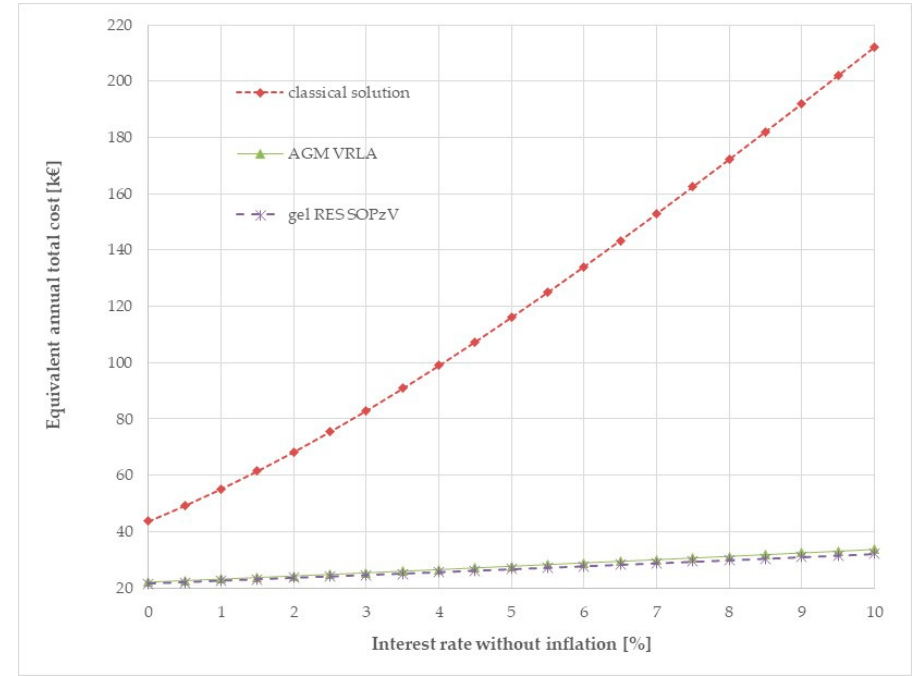
Figure 19. Equivalent annual total cost with respect to the interest rate without inflation for the best combinations of PVs, battery type (AGM VRLA or gel RES SOPzV), and capacities (according to Table 10) against the medium voltage submarine connection with the Aegina Island (classical solution).